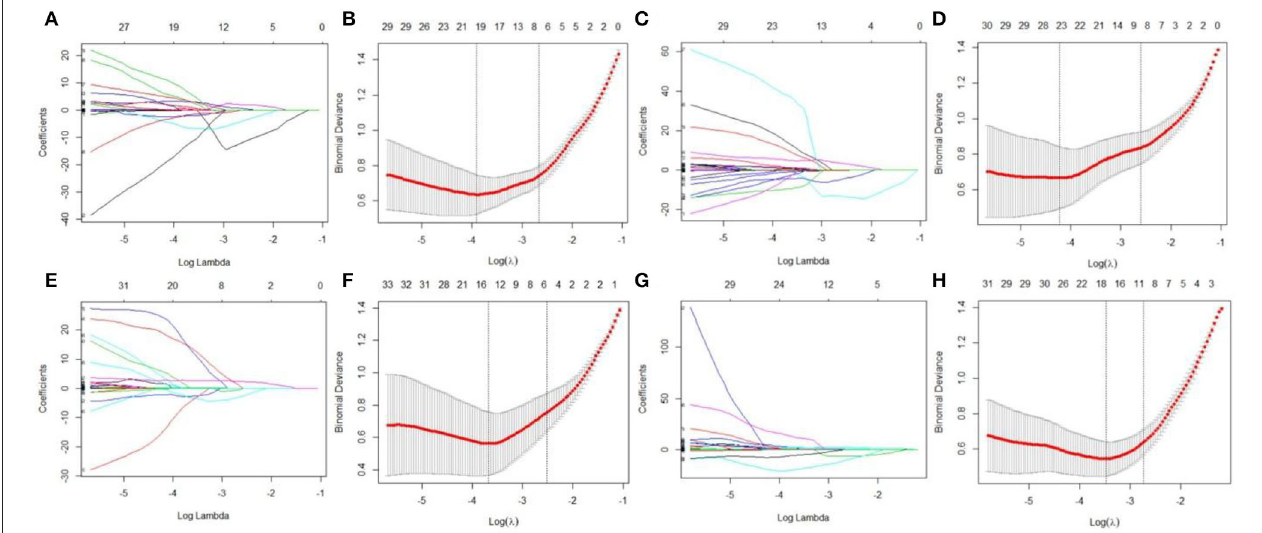
FIGURE 4 | Dimensionality reduction of features with LASSO regression between control and each SPS group. Each colored line represent coefficients of texture features, which are plotted vs. ln(lambda) in the mPFC radiomics signatures between the control and each SPS group: (A) control vs. SPS 1d; (C) control vs. SPS 4d; (E) control vs. SPS 7d; (G) control vs. SPS 14d. The binomial deviances are plotted vs. ln(lambda) in mPFC radiomics signatures between control and each SPS group: (B) control vs. SPS 1d; (D) control vs. SPS 4d; (F) control vs. SPS 7d; (H) control vs. SPS 14d. Red points indicate average values of deviance for each lambda; two dotted vertical lines correspond to lambda in minimum criteria and one standard error of minimum